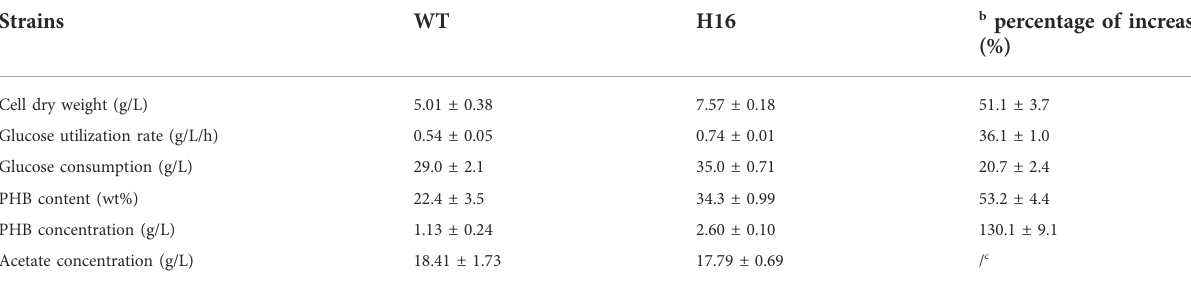
TABLE 4 Fermentation results of H16 for PHB accumulation using high-copy-number plasmid a .